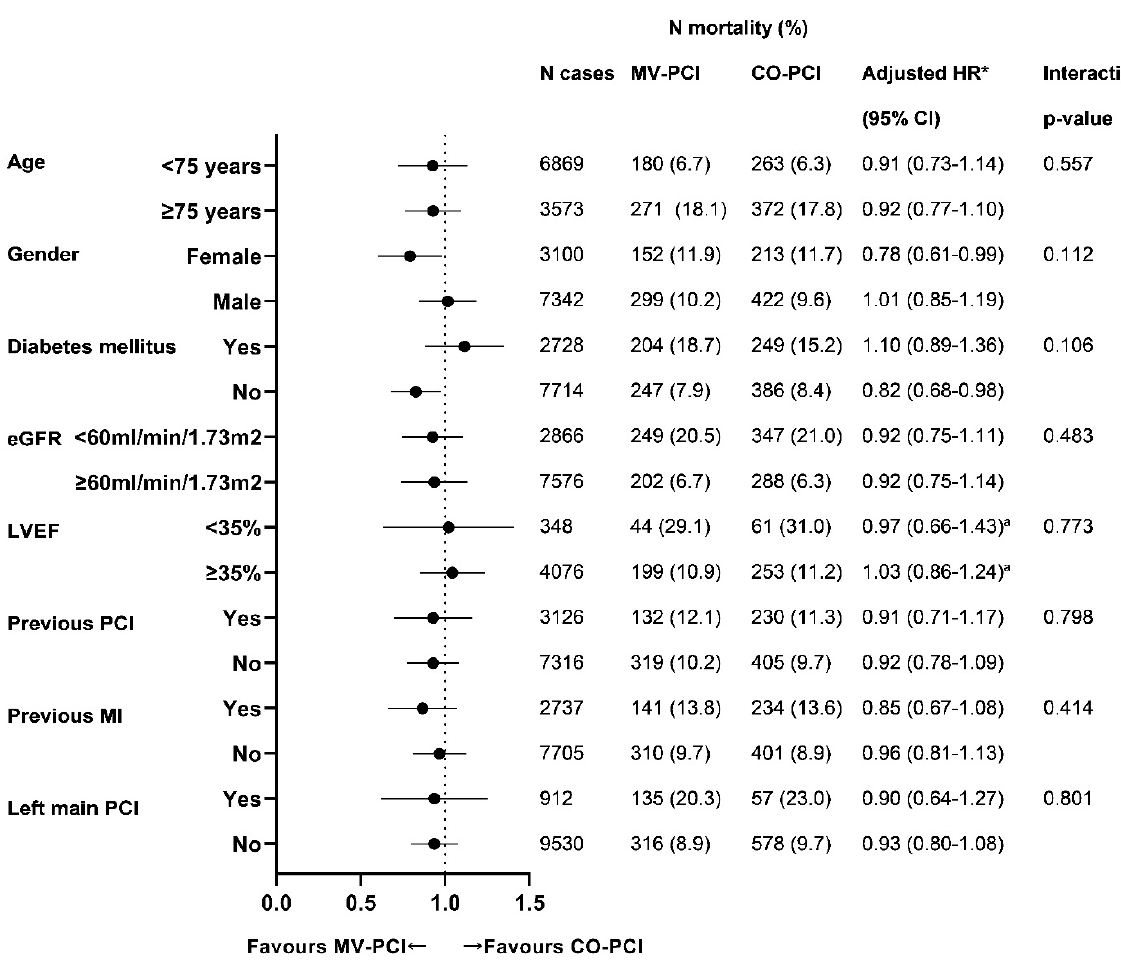
Figure 3. Subgroup analysis on mortality at long-term follow-up between MV-PCI and CO-PCI. Values are n (%), or HR (95% CI). CI, confidence interval; HR, hazard ratio; other abbreviations as in Figure 1, Tables 1 and 3. * Covariates used for correction: age, gender, creatinine level <60 mL/min/1.73 m 2 , diabetes mellitus, dialysis, previous MI, radial approach, left main PCI and vessel treatment. a Data depicted represent unadjusted HR due to missing data assumed to be not missing at random.